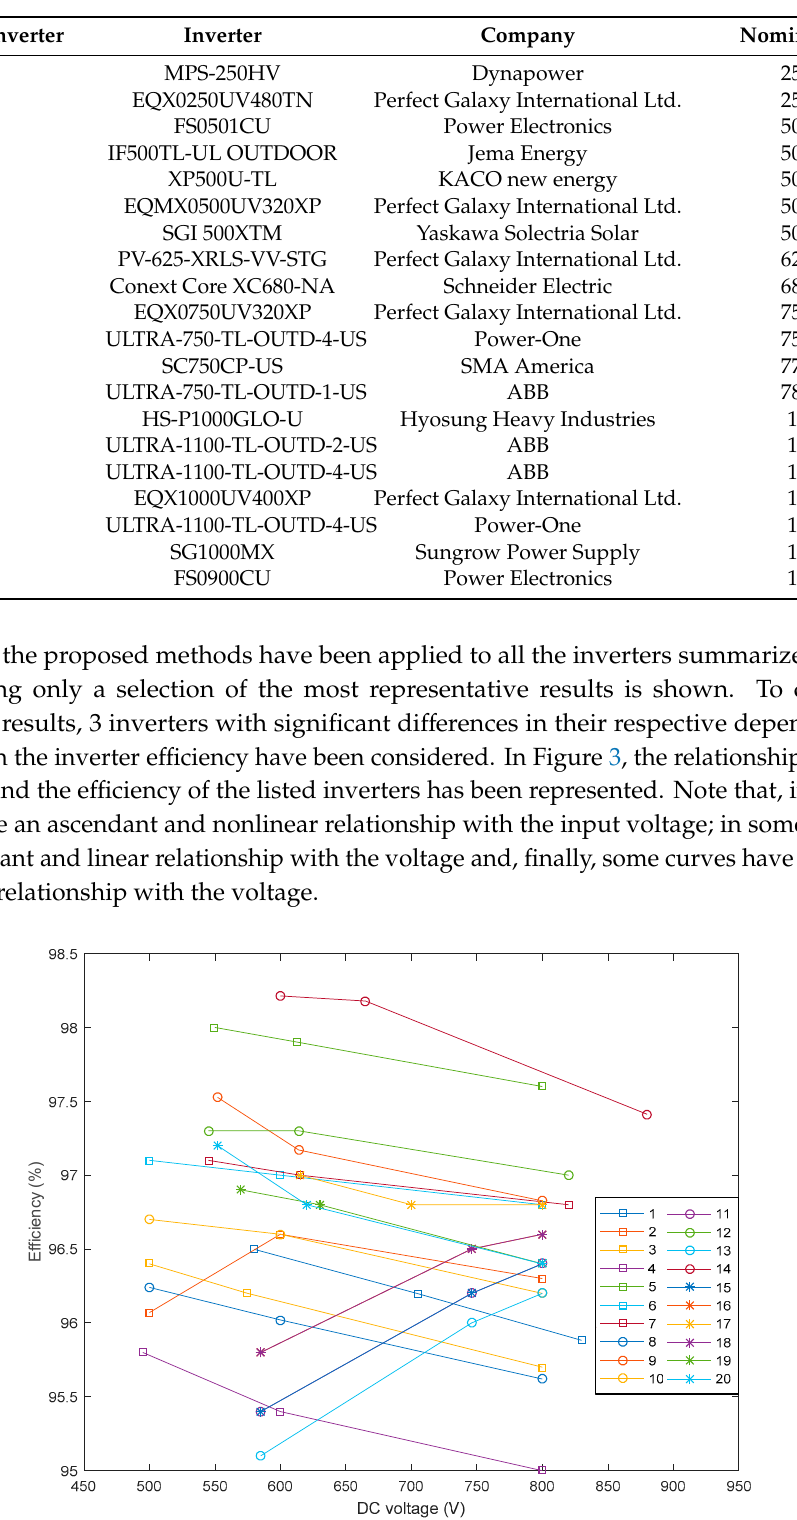
Table 1. List of inverters under study (Source: CEC (California Energy Commission) Grid Support Inverters List).